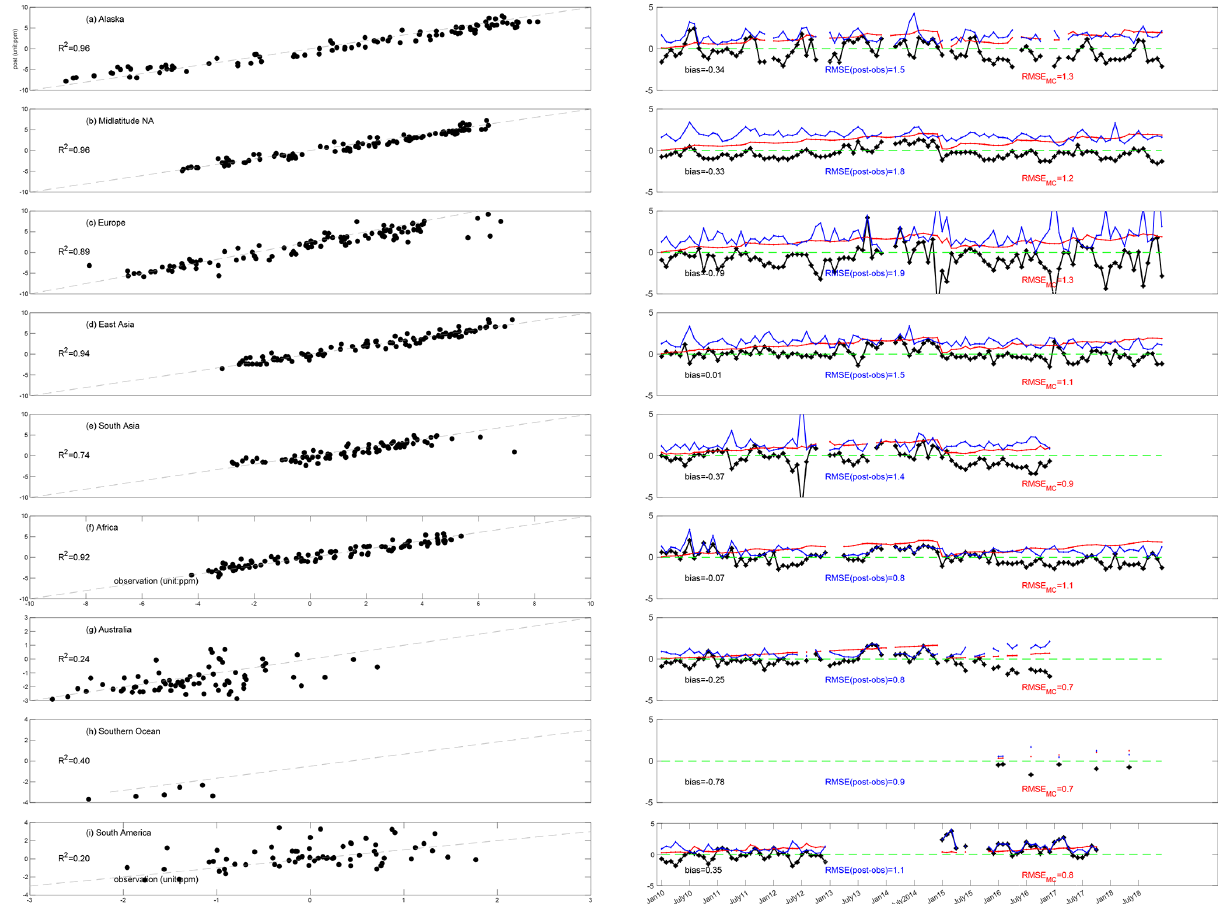
Figure 9. Comparison between posterior CO 2 mole fraction and aircraft observations. Left panel: detrended posterior CO 2 ( y axis) vs. de- trended aircraft CO 2 ( x axis) over nine regions. The dashed line is the one-to-one line; right panel: the differences between posterior CO 2 and aircraft CO 2 as a function of time (black), RMSE (blue; unit: ppm), and RMSE MC